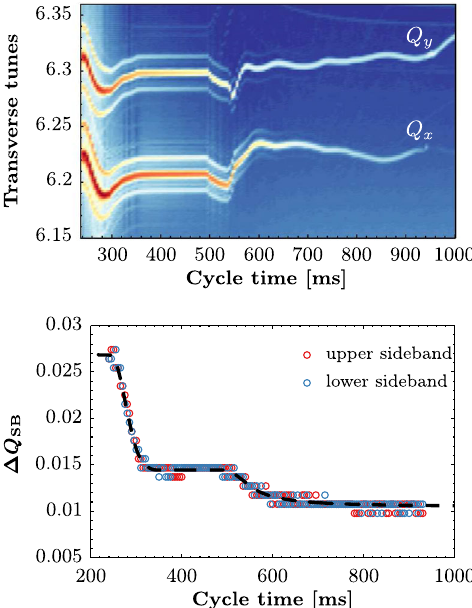
FIG. 4. Top: Tune measurement along an argon ion cycle. The average value over 900 cycles is shown. Sidebands are visible in both planes. Bottom: Distance of the sidebands from the horizontal tune. The dashed line corresponds to the expected ¼ 5 kHz from the main distance of the sideband frequency f SB tune peak along the